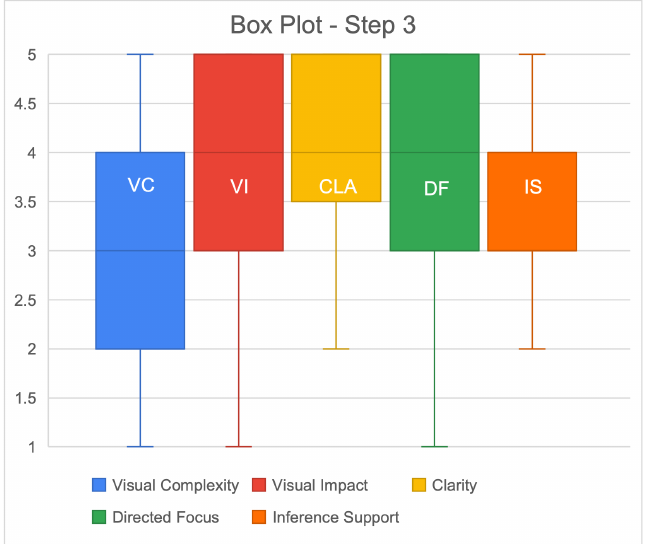
Figure 7. Boxplot chart for the results associated with the visual characteristics of Step 3 instructions— unplug the power cables from the energy